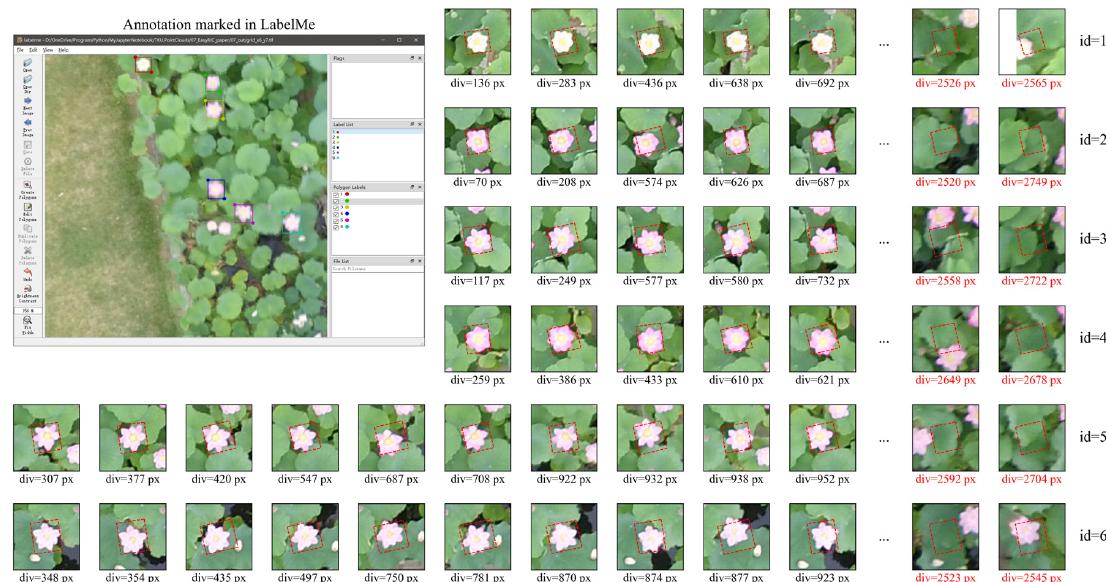
Figure 9. Potential usage of reverse calculation for organ-level training data annotation and augmentation in deep learning. The DOM file of dataset 5 (lotus) was split into several 500 px × 500 px grids, and the grid “x6-y7” was marked with 6 annotation rectangles for flowers by LabelMe. Reverse calculation was performed on all annotation rectangles for all raw images. “div” means the distance from the annotation center to the image center; smaller is closer.